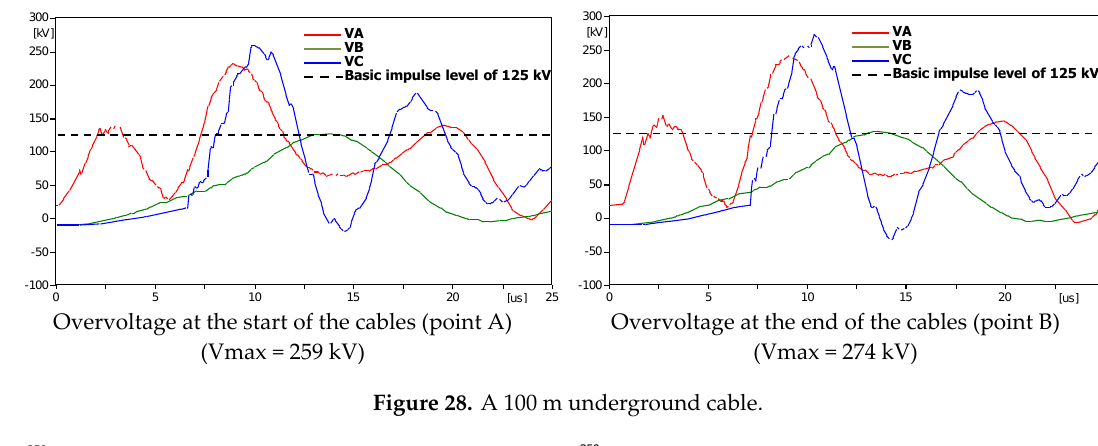
Table 6. Maximum overvoltage (kV) at points A and B, where the current of the lightning strike to point A is 40 kA.